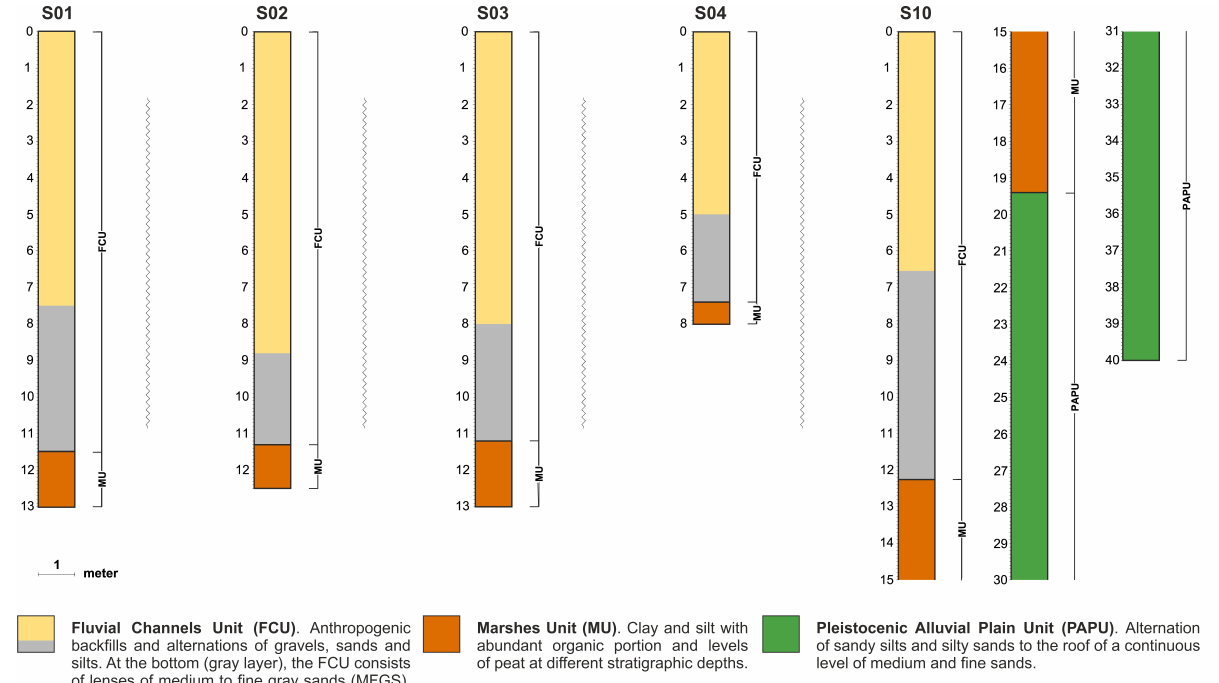
Fig. 2. Five borehole logs used to calibrate the ERT (see Fig. 1 for each borehole